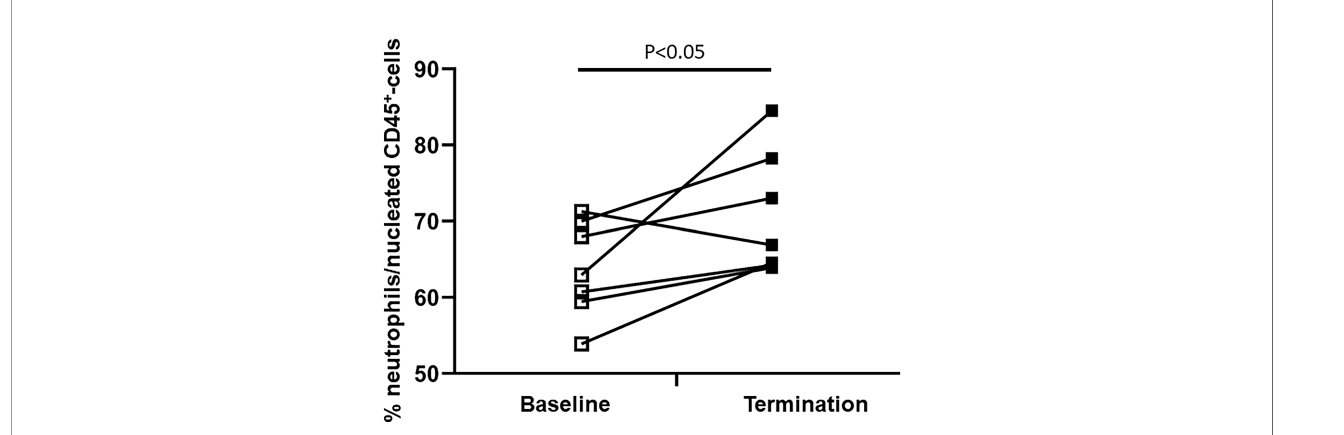
FIGURE 4 | Difference in the bone marrow neutrophil fraction between baseline and termination. The BM-neutrophil pool/fraction has been identi fi ed as described in Figure 2 .